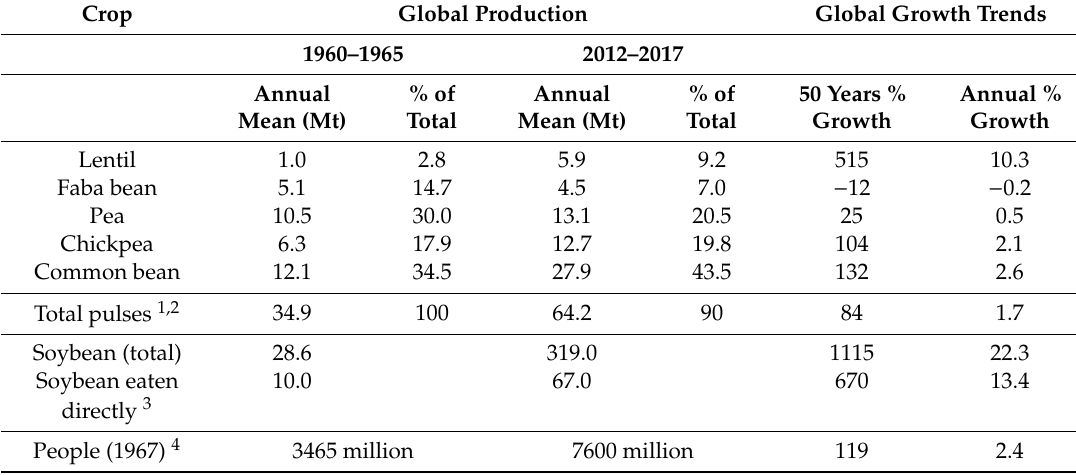
Table 1. Global trends of production of selected annual pulse crops in comparison to increases in soybean production and the global human population since